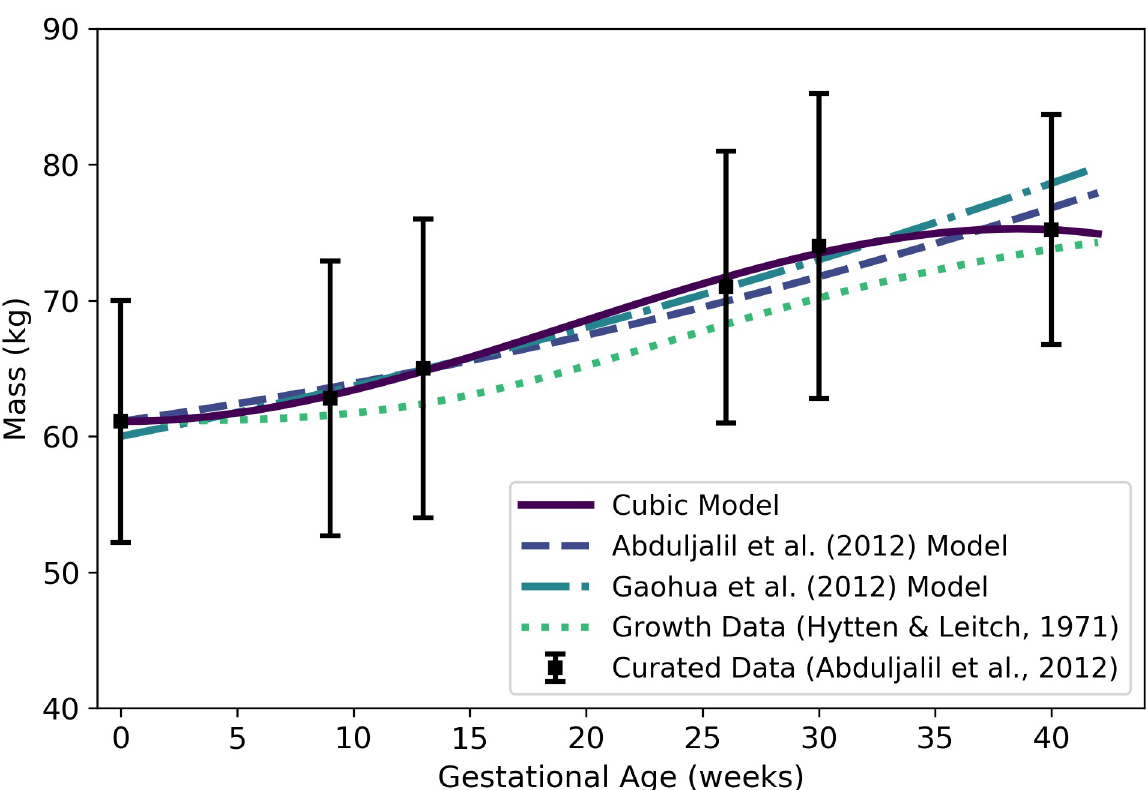
Fig 1. Mass of a human mother vs. gestational age. The cubic model (solid line) given by Eq 1 was selected as the most parsimonious model in our analysis. The models of Abduljalil et al. [28] and Gaohua et al. [29], both quadratic, were calibrated using the same curated data set [28] used by us. The maternal mass gain data (or “growth data”) depicted here were modified from the source [48] to account for an assumed initial mass as described in the text. Note that all models depicted here describe the mass of the entire maternal body plus the products of conception (including the fetus, placenta, and amniotic